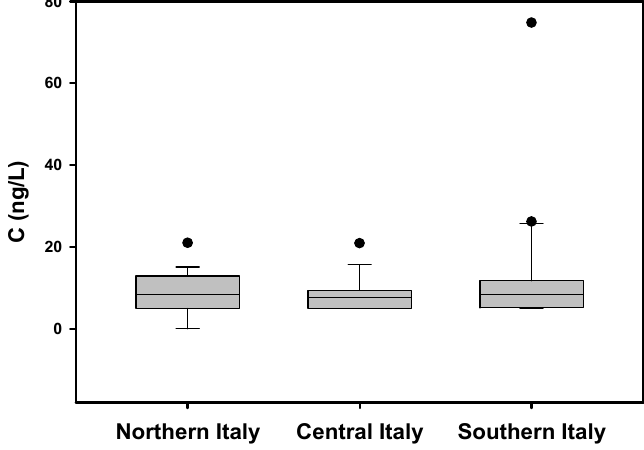
Figure 2. Map of sample regions of Italy. Perchlorate concentration is represented by